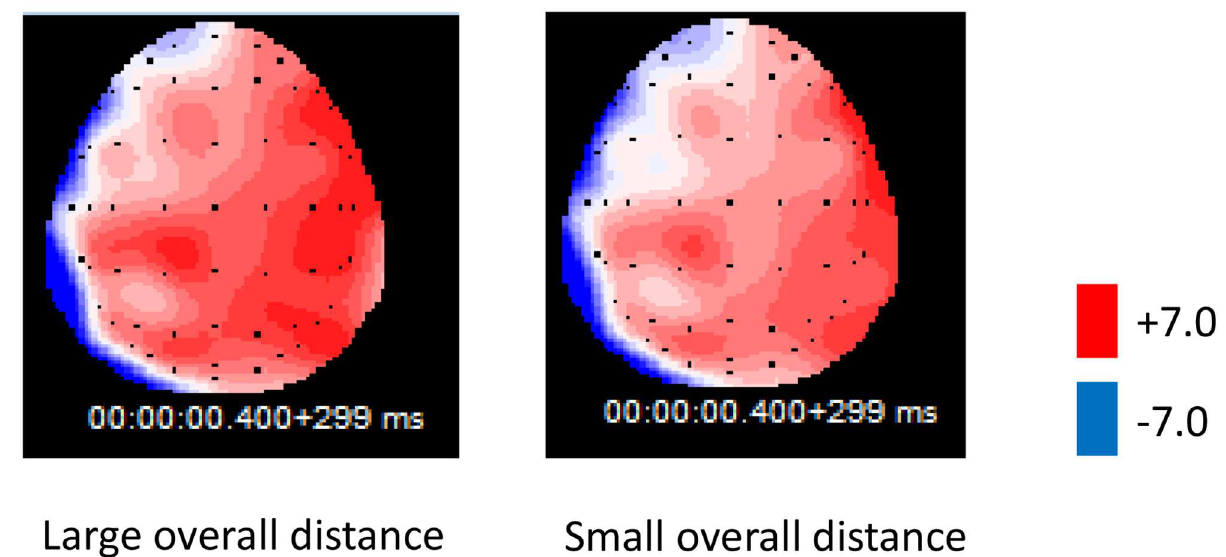
Fig 7. Topography of ERPs for the large overall distance and small overall distance condition